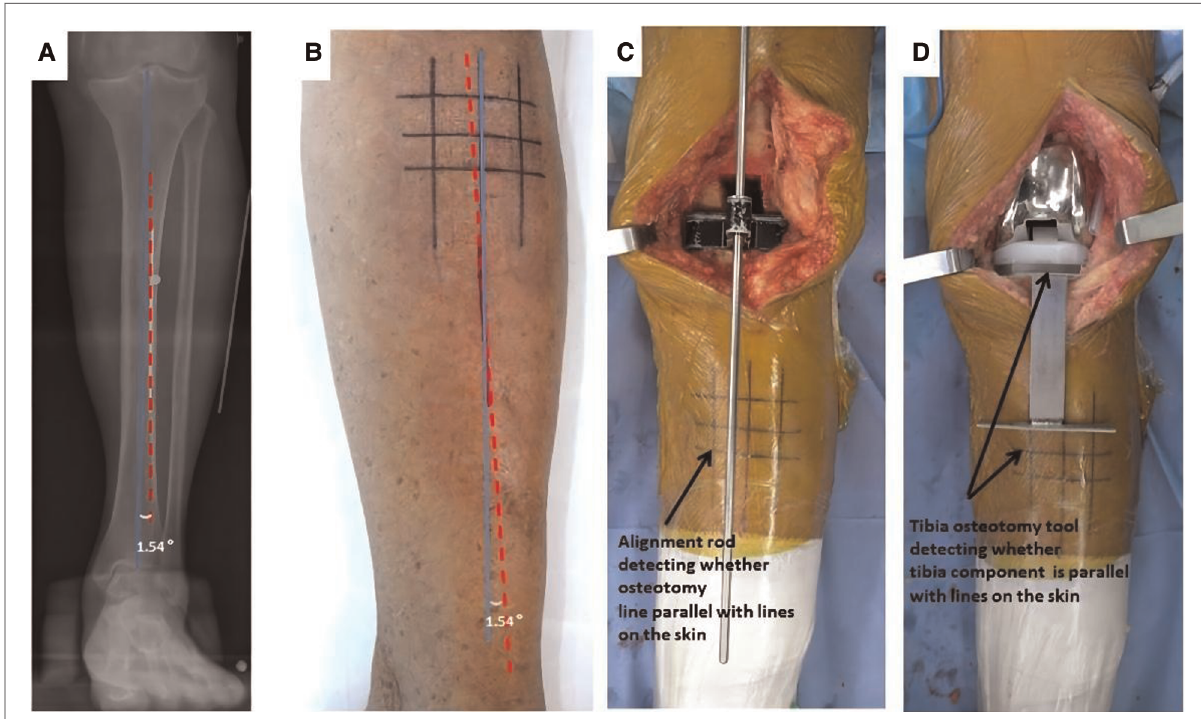
FIGURE 3 The TMA mapped on the skin before TKA surgery. ( A ) The MTCL – TMA angle is measured by PACS software. ( B ) The TMA lines are marked on the skin, modulated by the MTCL – TMA angle. The parallel and vertical TMA lines are marked for TKA. ( C ) After tibial osteotomy, an alignment rod is used to detect whether the alignment matches the skin markings. ( D ) The position of the tibial component is double-checked using a specialized